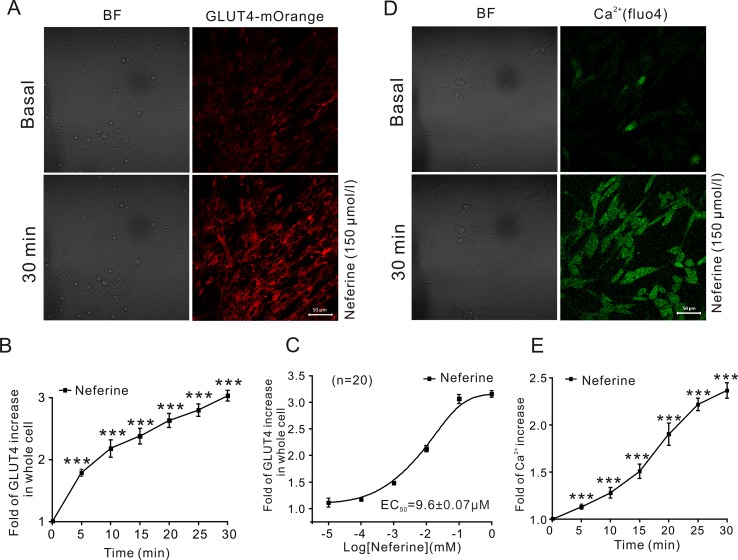
Neferine upregulates GLUT4 expression and intracellular Ca2+. (A) Images of 150 μM neferine stimulating GLUT4 expression in L6 cells. Scale bar = 50 μm. (B) Calculation of fluorescence intensity in myc-GLUT4-mOrange L6 cells using Zen 2010 software. (C) Neferine-induced GLUT4 expression occurred in a dose-dependent manner. (D) Images of 150 μM neferine increasing the intracellular Ca2+ concentration in L6 cells. Scale bar = 50 μm. (E) Calculation of fluorescence intensity in L6 cells using Zen 2010 software. Data represent the fold increase in neferine-induced fluorescence between 0 and 30 min. ***P < 0.001.